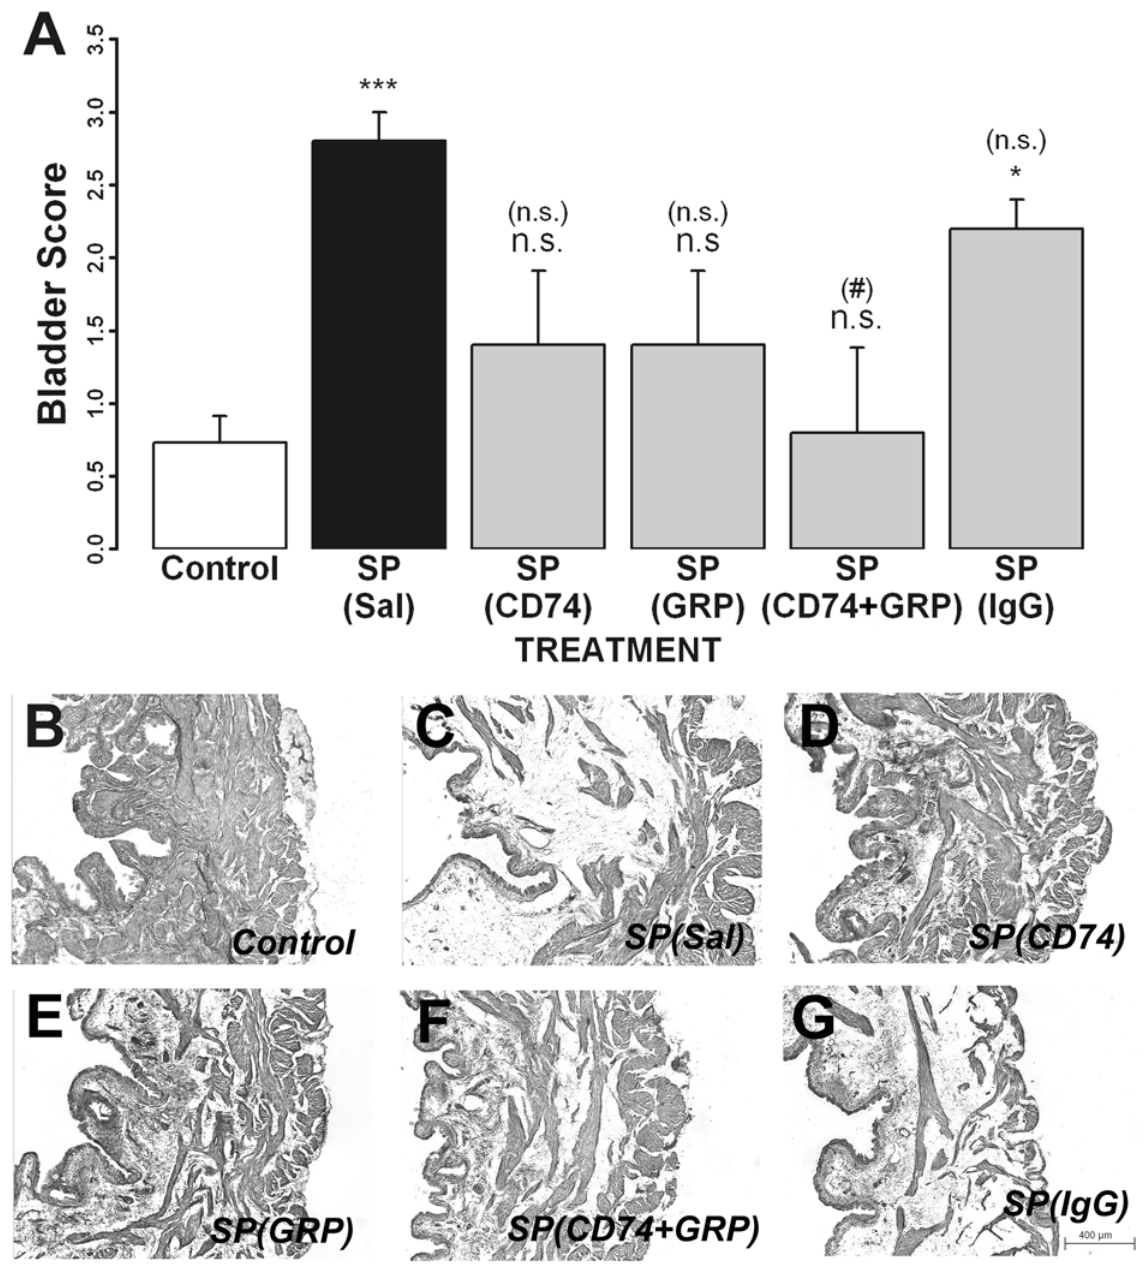
Figure 4. Effect of different intraluminal treatments on substance P (SP)-induced histological changes. A) Bladder inflammation scores across all treatment groups (intraluminal treatment for each group is in parenthesis). Substance P produced bladder edema and inflammation when compared to the control group. Groups treated with CD74 ab (CD74) and/or GRP78 ab (GRP) had bladder scores that were not significantly different from control. B–G. Representative H&E stained bladder sections from each group. *=comparison to saline p , 0.05; ***=p , 0.001; ( # )=comparison to SP(Sal) p , 0.05;( ### )=p , 0.001; n.s.=not significant. doi:10.1371/journal.pone.0005835.g004 antibodies were omitted in control sections. Slides were examined using a Leica DMI4000B (Leica Microsystems Inc, Wetzlar, Germany) microscope.